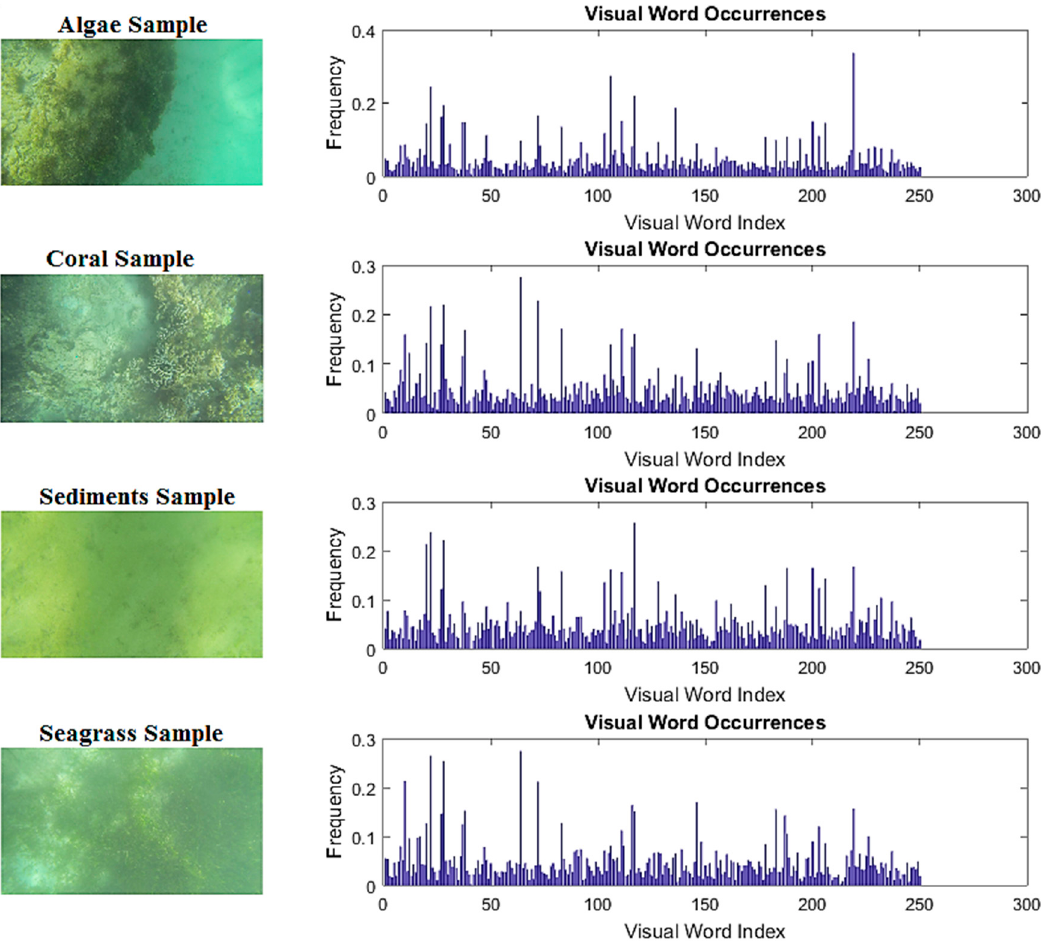
Figure 5. Various examples of categorized images, and a sample of their visual words occurrences over the Shiraho area.